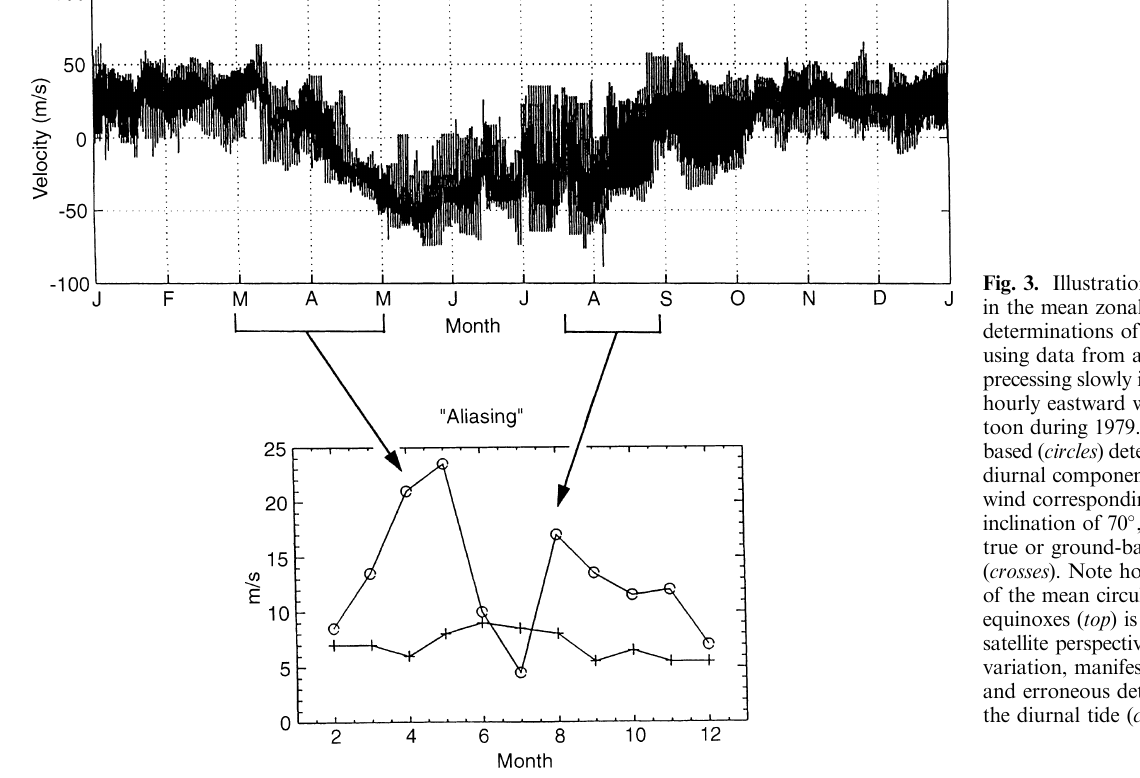
Fig. 4. Illustration of how removing the mean component from the data (i.e., using a running mean or low-pass filter) prior to tidal analysis can lead to improved determinations of tidal components from space-based data. All panels correspond to the amplitude of semidiurnal component of eastward wind assuming ascending and descending node data (24-h local-time coverage) at the latitude of Saskatoon (52 (cid:14) N) for a satellite inclination of 70 (cid:14) . Space-based determinations are given by circles , and true results (same for all panels) are given by crosses . The top panel corresponds to the same data sets and method of analysis used in Figs. 1 and 3. The middle panel results from analysis of the 24-h (local:time) running mean of the data (i.e., the tides are removed) from the satellite perspective; the nonzero tidal amplitudes thus result solely from temporal variations in the mean component aliasing into the tidal determination. The bottom panel illustrates tidal determinations based on the residuals from the 24-h sliding fit, i.e., with the mean removed. Note the improvement over the